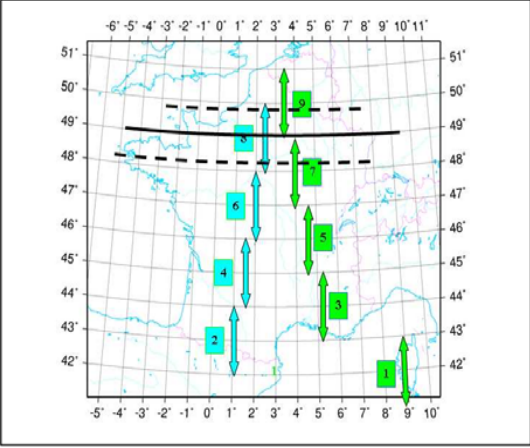
Figure 8: Layout of the “Lambert 9 zones” conformal conic projections for France used to minimise scale error. Source: http://geodesie.ign.fr/index.php?page=documentation